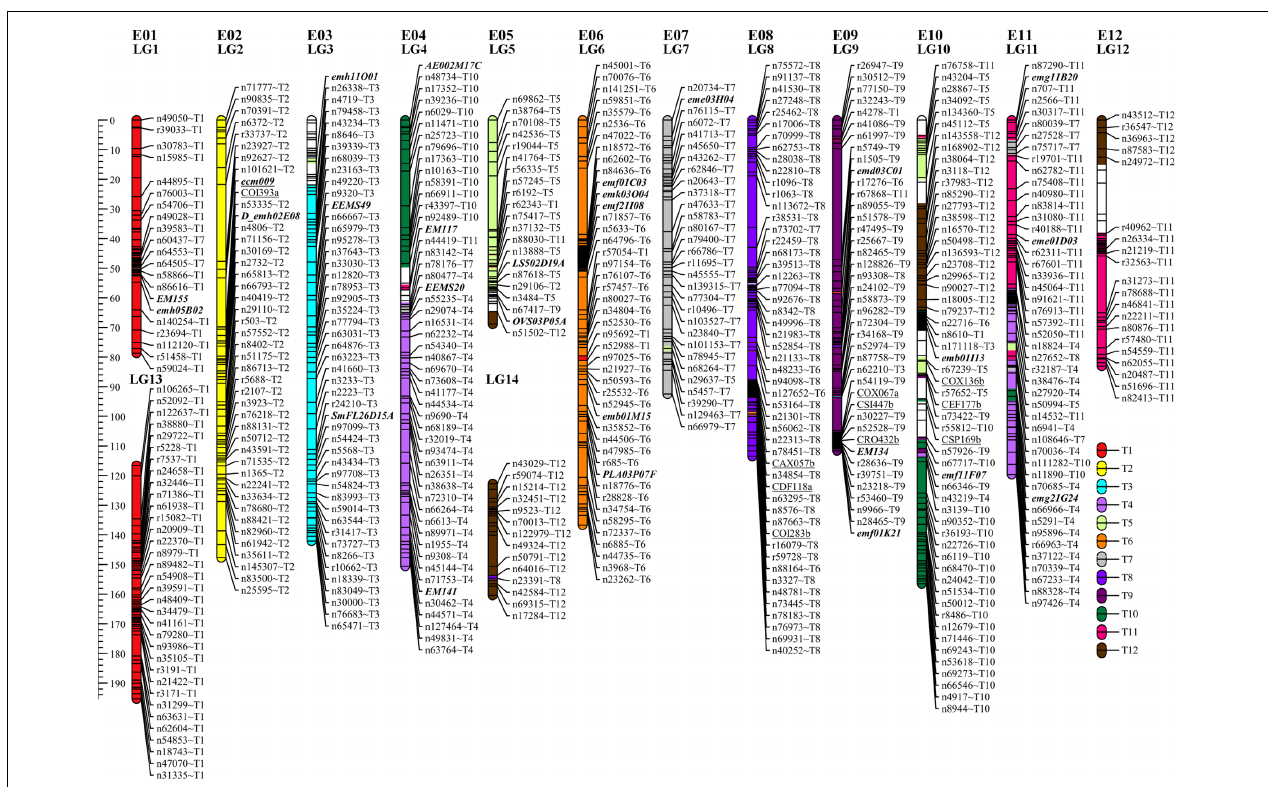
FIGURE 1 | Genetic map of eggplant [MM738 × AG91-25] RIL population anchored on eggplant and tomato chromosomes. Tomato chromosomes syntenic to eggplant chromosomes are indicated by the suffix “Tx” at the end of each marker name. They are illustrated with a color code (key at the bottom right of the figure). SSR markers are indicated in bold italics; SNPs from the de novo pipeline are indicated with the prefix “n”; SNPs from the reference guided pipeline are indicated with the prefix “r.” Markers previously associated with QTL resistance in Lebeau et al. (2013) are underlined. The names of 522 markers were removed to ensure good visibility on the map (for more details, see Supplementary Table S3). LG, linkage group; E01–E12, the 12 eggplant chromosomes.